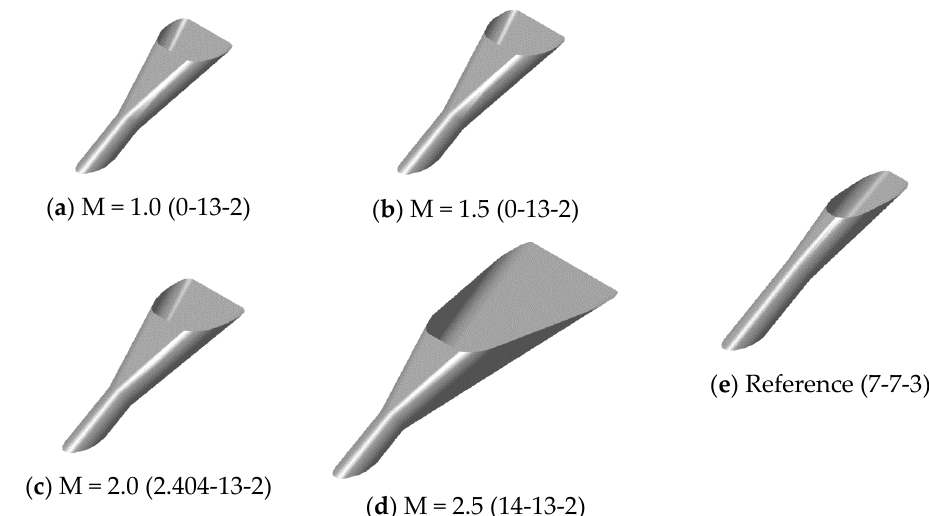
Figure 11. Optimized holes at DR = 2.0 ( u m = 90 m/s ).